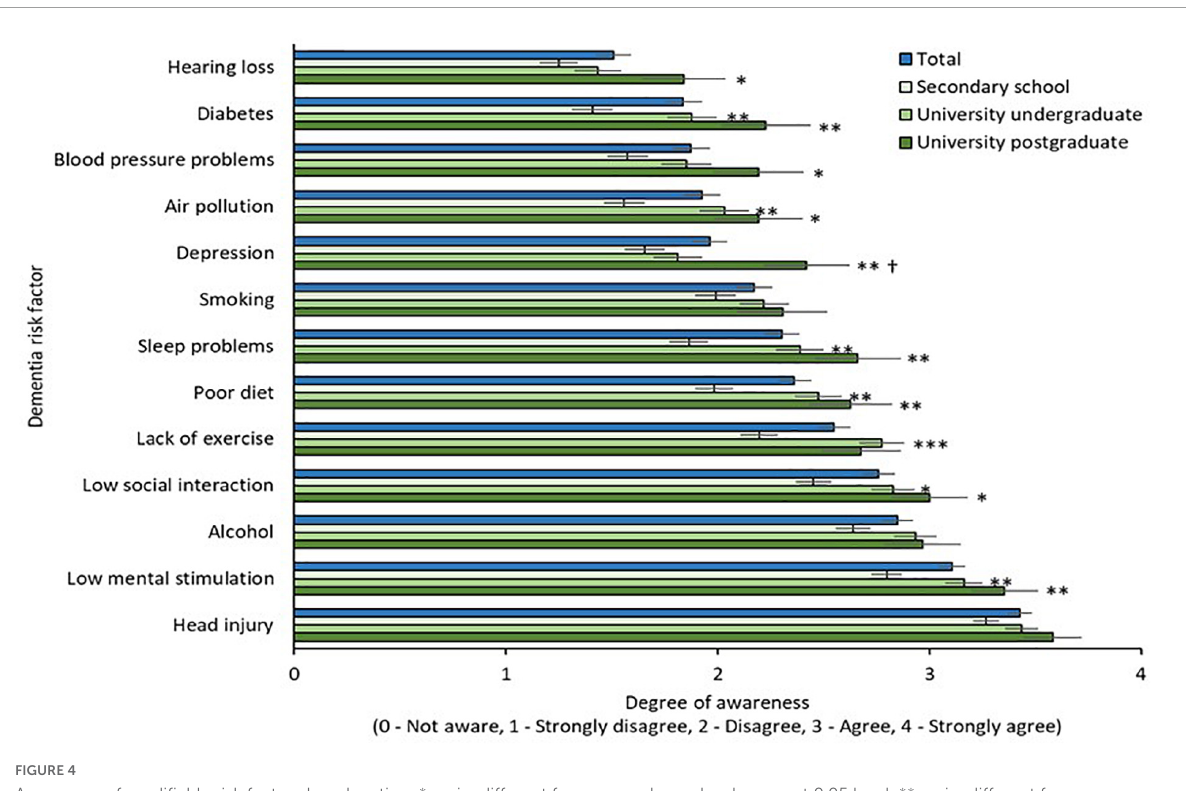
FIGURE4 Awareness of modifiable risk factors by education. ∗ = sig. different from secondary school group at 0.05 level; ∗∗ = sig. different from secondary school group at 0.01 level; ∗∗∗ = sig. different from secondary school group at 0.001 level; † = sig. different from university undergraduate group at 0.05